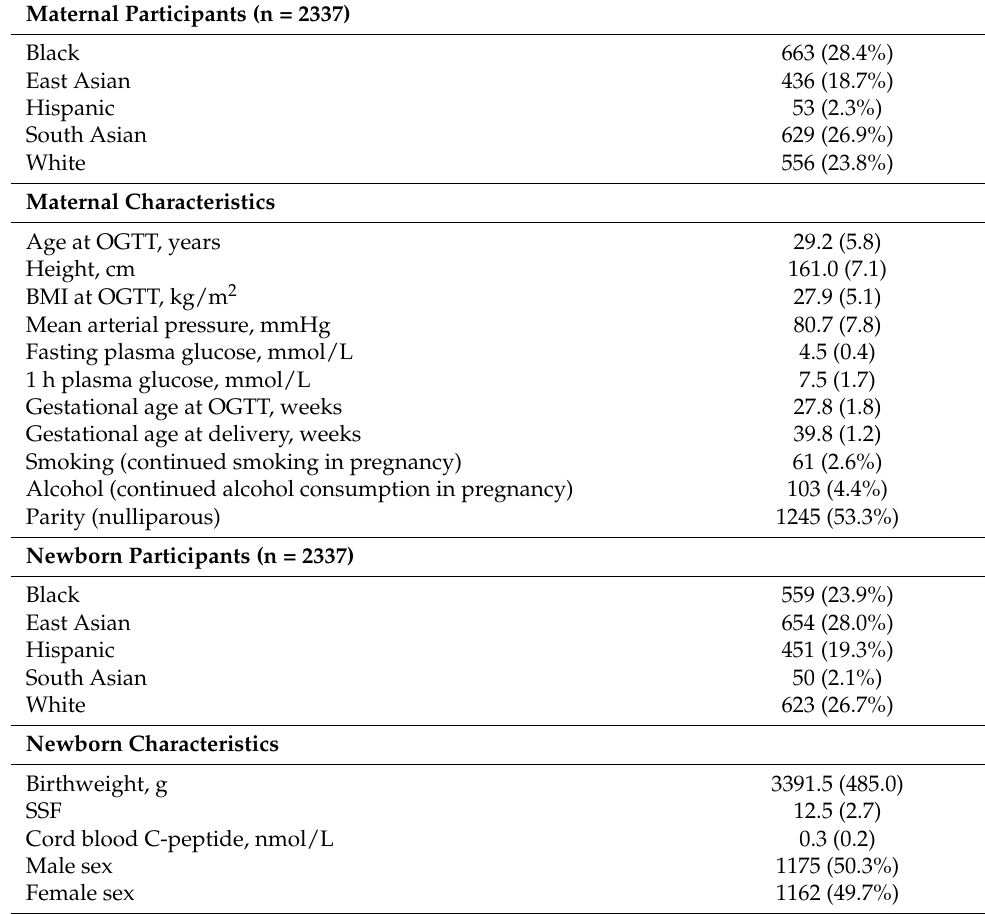
Table 1. Characteristics of participating mothers and